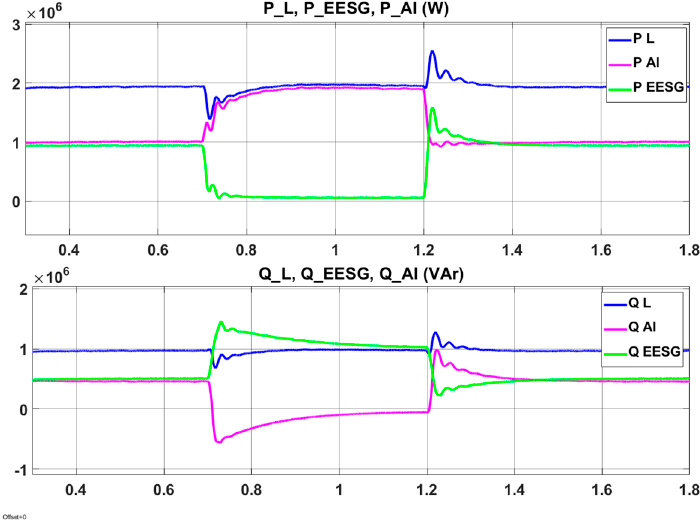
Figure 18. Energy processes in the operation of the mechatronic DG–SG system during a change from k = 0.5 to k = 0 (minimum fuel consumption of the diesel engine of the DG set) and then back to k = 0.5.